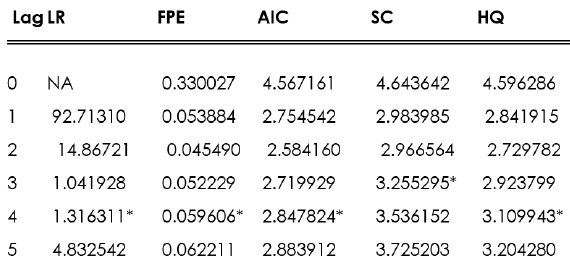
Table 4. Lag Length Criteria